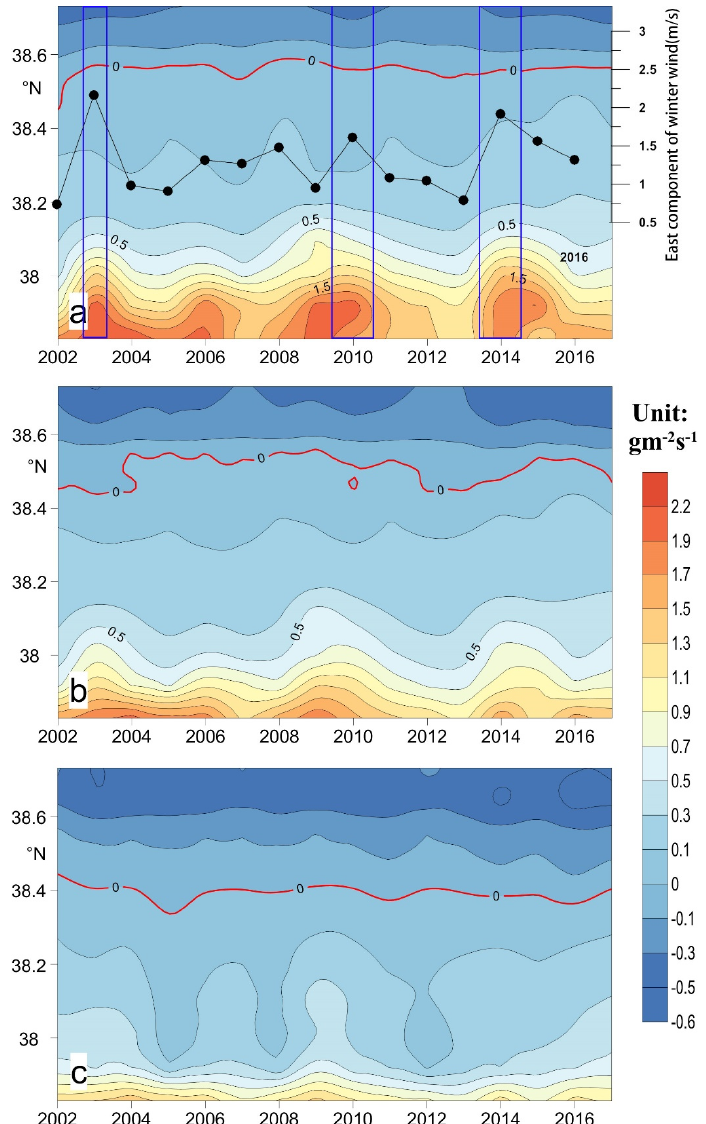
Figure 8. Single-width fluxes in the Bohai Strait at the surface layer ( a ), middle layer ( b ), and bottom layer ( c ); Positive values indicate output flux from the Bohai Sea to the Yellow Sea, and negative values indicate input flux from the Yellow Sea to the Bohai Sea; The red line represents the boundary between the input flux and the output flux.